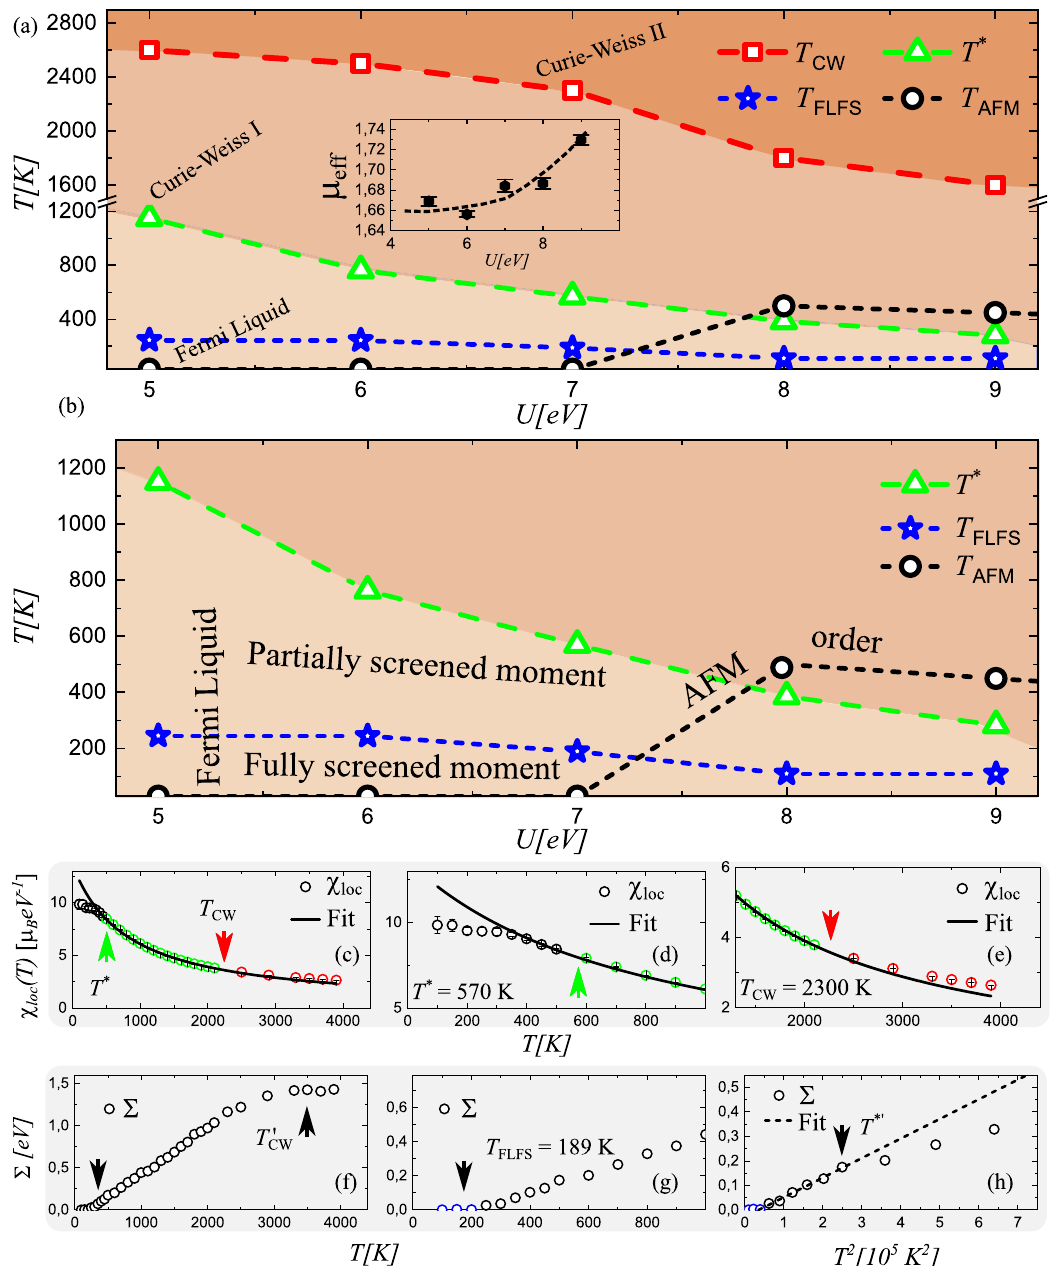
Fig. 1 Correlation-temperature phase diagram of LaNiO 2 . a shows the correlation-temperature ( U – T ) phase diagram where the boundaries of various electronic phases were determined from the fi ts of the calculated local magnetic susceptibility ( χ loc ) for the nickel d electrons, and scattering rate ( Σ ) for the electrons in the nickel d x 2 (cid:3) y 2 orbital. The susceptibility values and the corresponding error bars represent the mean and the standard deviation obtained from the last few converged iterations (usually 5) for each given calculation. The red ( T CW ) and green ( T * ) dashed lines denote the Curie – Weiss and Fermi liquid phase boundaries, respectively. The boundary (black dashed curve, T AFM ) of the antiferromagnetic (AFM) phase was obtained by computing the temperature dependence of the magnetic order parameter, described in the text. The inset shows the U dependence of the local effective moment μ eff , where the dashed line is a guide to the eye. b shows the low-temperature region of the U – T phase diagram, showing the regions of partially screened and fully screened (below T FLFS ) Fermi liquid phases. c shows the temperature dependence of the calculated χ loc for the Ni-d electrons for U = 7 eV and J = 1 eV. d , e show χ fi t with the loc with the focus on the low- and high- temperature ranges, respectively. The solid line represents the best C μ 2 eff ffiffi p Curie – Weiss – Wilson formula χ loc ¼ as explained in the text. From d , e , we observe that T * and T CW corresponds to the temperatures where χ loc ð T þ T (cid:1) Þ 2 shows deviations from the Curie – Weiss behavior. f shows the temperature dependence of the calculated scattering rate ( Σ ) for the electrons in the Ni d U and J used for the susceptibility. g , h focus on the low-temperature region, where Σ is plotted vs. T and T 2 , x 2 (cid:3) y 2 orbital, for the same value of Þ , where A > 0. T 0 respectively. The dashed line represents the best linear fi t with the formula Σ = A ð T 2 (cid:3) T 2 , T (cid:1)0 and T FLFS are the temperatures at FLFS CW which Σ fl attens at high-temperature, the system starts to show a Fermi liquid behavior (linear dependence of Σ on T 2 ), and Σ goes to zero at low- temperature respectively. Note that T (cid:1)0 ≈ T * . The arrows show the position of various characteristic temperatures.